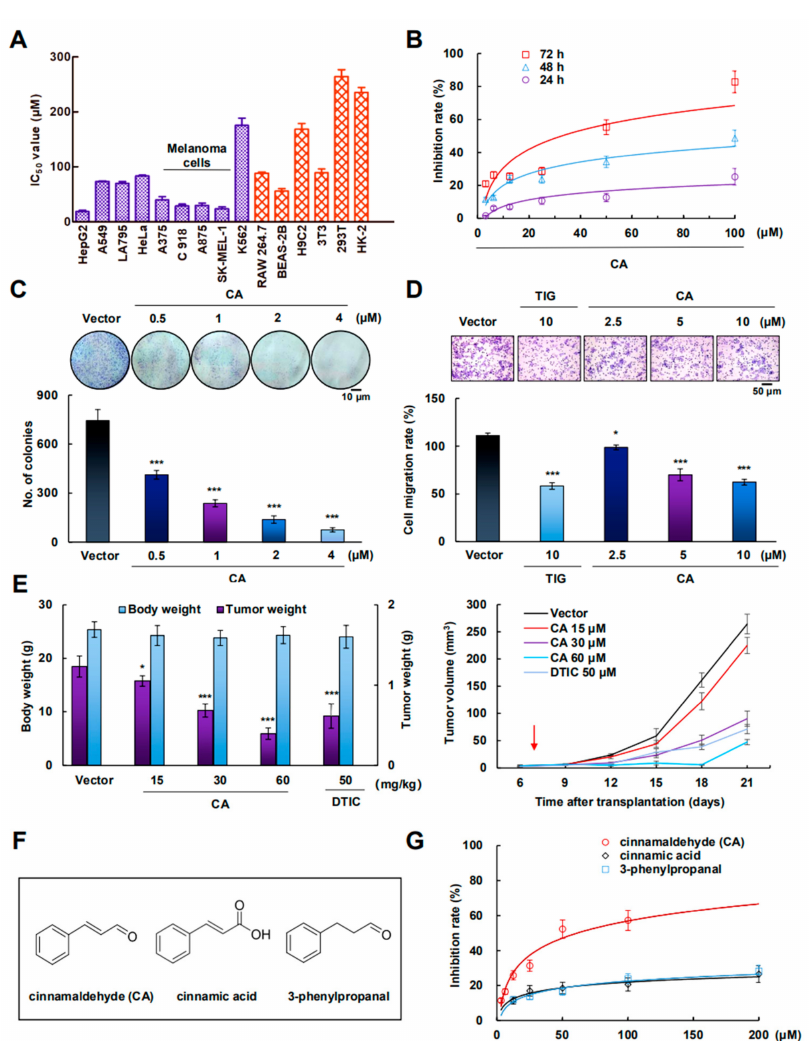
Figure 1. Cinnamaldehyde (CA) inhibits the proliferation of A375 cells. ( A ) The di ff erent tumor cell lines (purple) and normal cell lines (red) were treated with 0, 6.25, 12.5, 25, 50, 100, 200, or 400 µ M CA for 72 h, and then IC 50 value was assayed. ( B ) A375 cells were treated with 0, 6.25, 12.5, 25, 50, or 100 CA for 24, 48, or 72 h, and the cell viability was assayed. ( C ) A375 cells were treated with 0, 0.5, 1, 2, or 4 µ M CA for 12 days, and Giemsa staining was used to conduct colony-formation assays; the histogram shows the number of colonies ( n = 3), scale bar: 10 µ m. ( D ) Cells were treated with tigecycline (TIG, 10 µ M as a positive control) or CA (0, 2.5, 5, or 10 µ M) for 24 h, and the migration rate was normalized by proliferation ( n = 3), scale bar: 50 µ m. ( E ) A375 cells were injected subcutaneously into nude mice. When the tumors were formed, mice were treated with dacarbazine (DTIC) (50 mg / kg / day as a positive control) and CA (15, 30, or 60 mg / kg / day) for 2 weeks (The red arrow at Day 7 represents the first day of treatment). Finally, the tumor tissues were measured, stripped, and weighed, and the tumor volume was calculated ( n = 6). ( F ) The structures of cinnamaldehyde (CA), cinnamic acid, and 3-phenylpropanal. ( G ) A375 cells were treated with di ff erent concentrations of 3-phenylpropanal, cinnamic acid, and CA for 72 h. The cell viability was assayed. Values represent the means ± SD. * p < 0.05, *** p < 0.001 versus “vector”